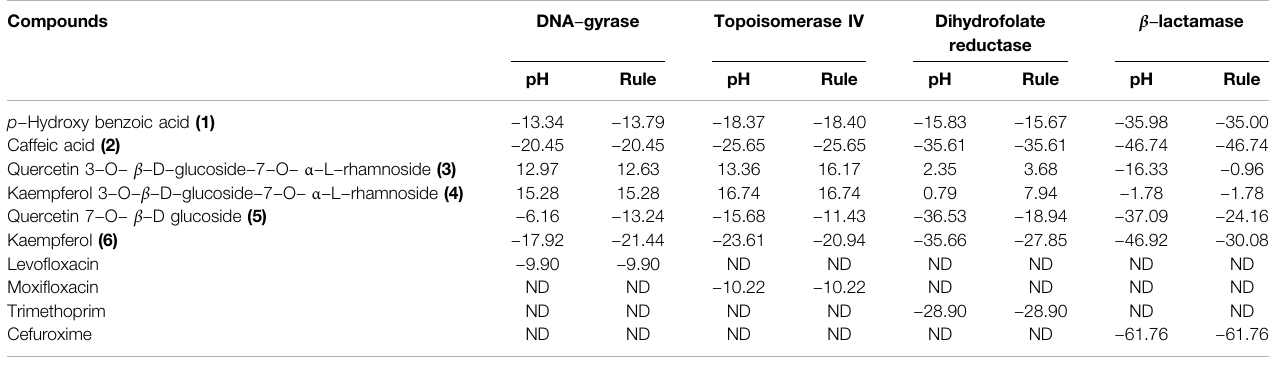
TABLE 3 | Free binding energies ( Δ G) in Kcal/mol of compounds isolated from B. indica Lam. leaves in the active sites of enzymes involved in the occurrence of bacterial infections and resistance using in silico studies. Compounds